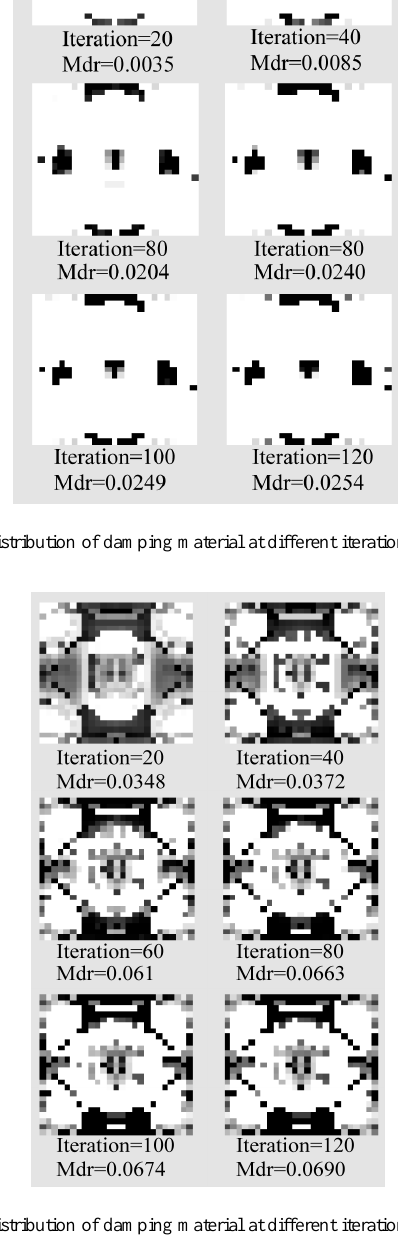
Fig. 19. Optimal distribution of damping material at different iteration numbers, vf =